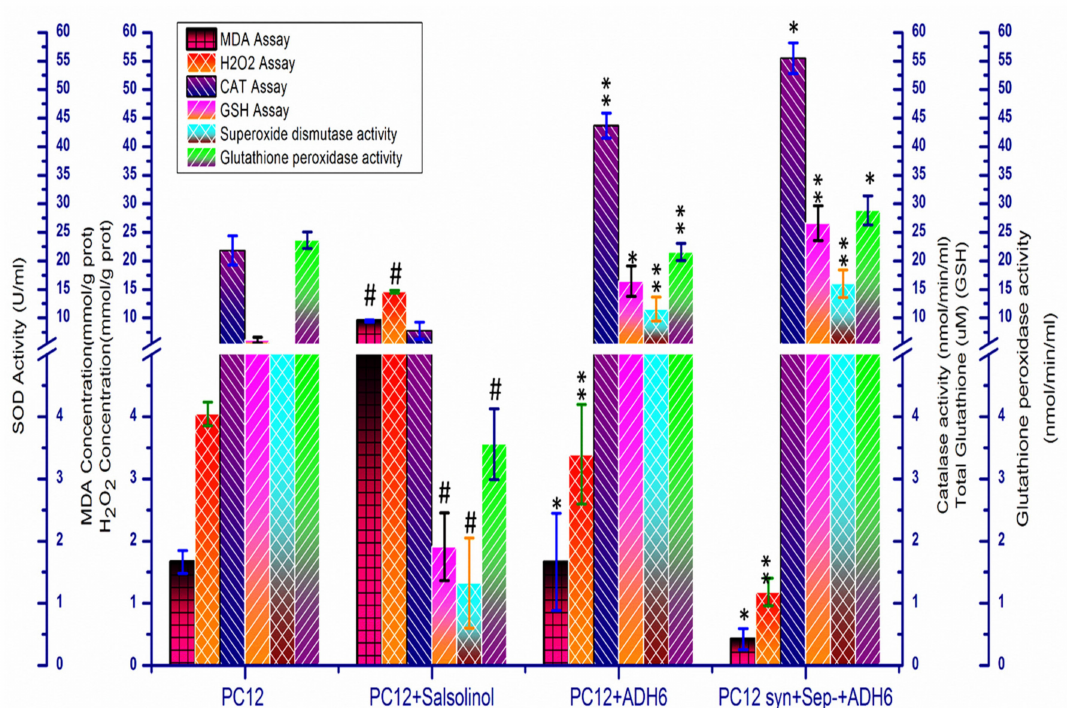
Figure 8. MDA assay, H 2 O 2 assay, CAT assay, GSH assay, superoxide dismutase activity assay, and glutathione peroxidase activity assay of the PC12 + syn + + sep − + ADH6 + cell line. The levels of MDA and H 2 O 2 were decreased in PC12 + syn + + sep − + ADH6 + cells compared to PoTwS cells. The activity of catalase and glutathione reductase activity, superoxide dismutase activity, and glutathione peroxidase was increased in the PC12-ADH6 + and PC12 + syn + + sep − + ADH6 + cell lines compared to PoTwS cells. Error bars represent the standard deviation of biological triplicates. The description of each cell line is given in Supplementary Table S3). Data are mean and S.E. values from three independent experiments ( n = 3). # p < 0.05, relative to control cells (PC12 cells). * p < 0.05 and ** p < 0.01, relative to the